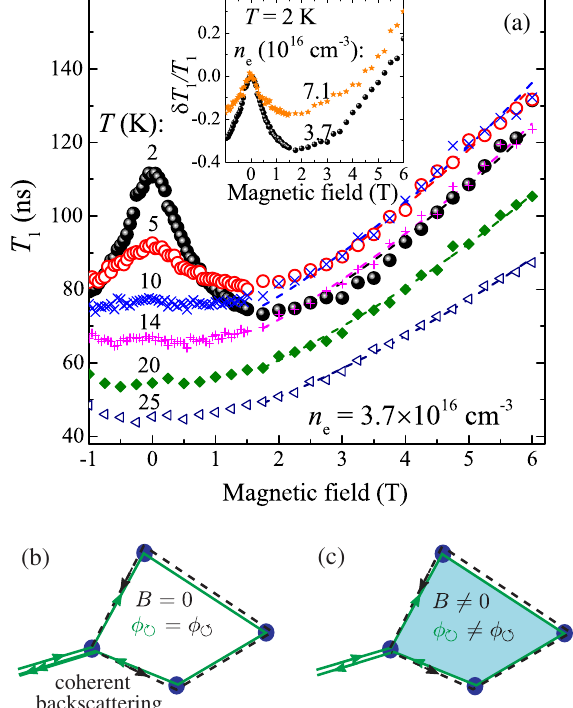
FIG. 2. Effect of weak localization on longitudinal spin relaxation time T 1 . (a) Magnetic field dependence of T 1 at 3 . 7 × 10 16 cm − 3 . The dashed lines different temperatures. n e ¼ show fits to the experimental data with Eq. (5). Inset shows relative variation of T 1 with magnetic field for metallic samples with different electron concentrations. (b) Scheme of constructive interference of clockwise and counterclockwise electron paths, starting at the same impurity and related by the time reversal symmetry. The interference gives rise to the weak localization effect by increasing the backscattering efficiency. (c) The inter- ference between the same paths as in Fig. 2(b) is destroyed by the magnetic field due to the extra phase acquired by the electron traveling clockwise and counterclockwise.